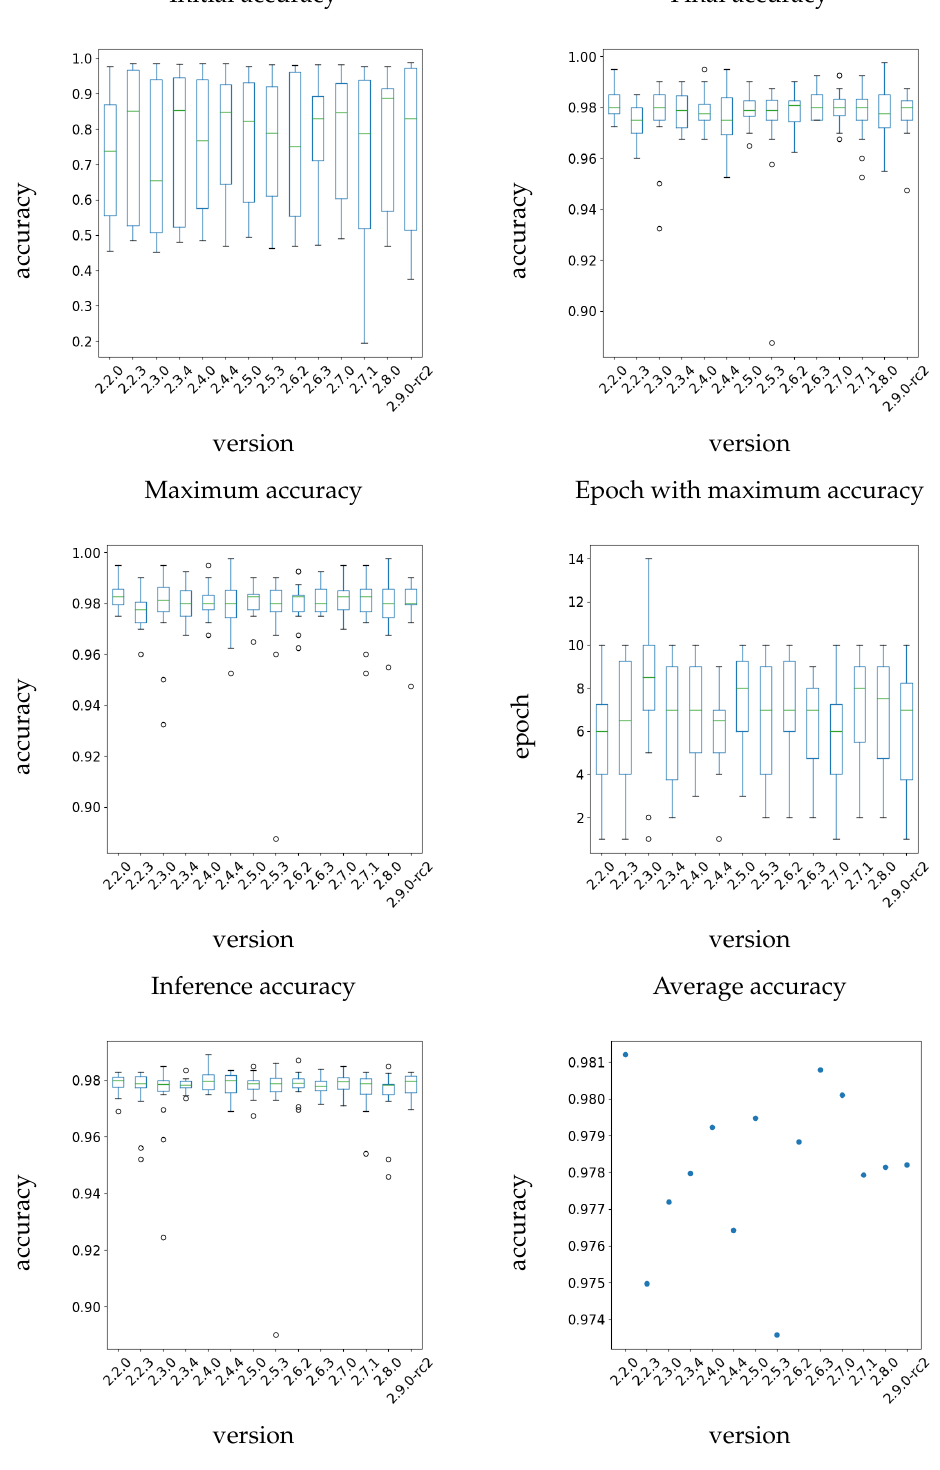
Figure 5. The results for the 2D Gaussian dataset using